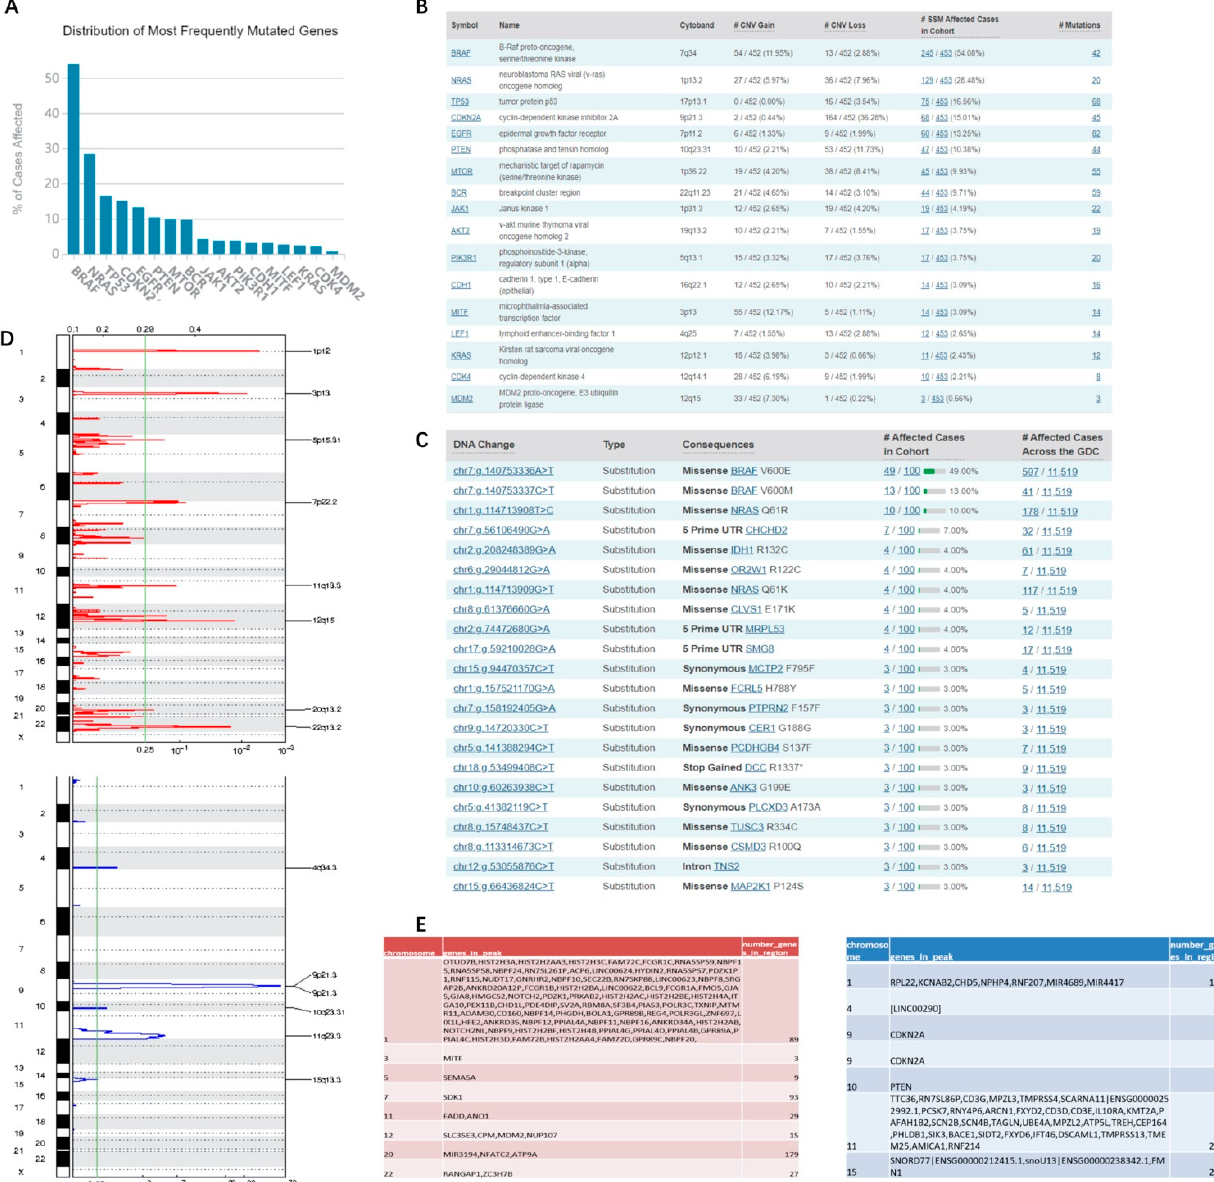
Figure 2. Most commonly mutated genes and mutation sites in melanoma: ( A – C ) melanoma tumor factor copy number variation and mutation sites in TCGA database; ( D , E ) GCDA broad institute analysis of melanoma tumor factor CNV in TCGA database. The x -axis represents the normalized upregulation (red) or downregulation signal (blue), and the green line represents the significance cutoff at Q = 0.25. In the table are the genes that are highly enriched on different chromosomes.